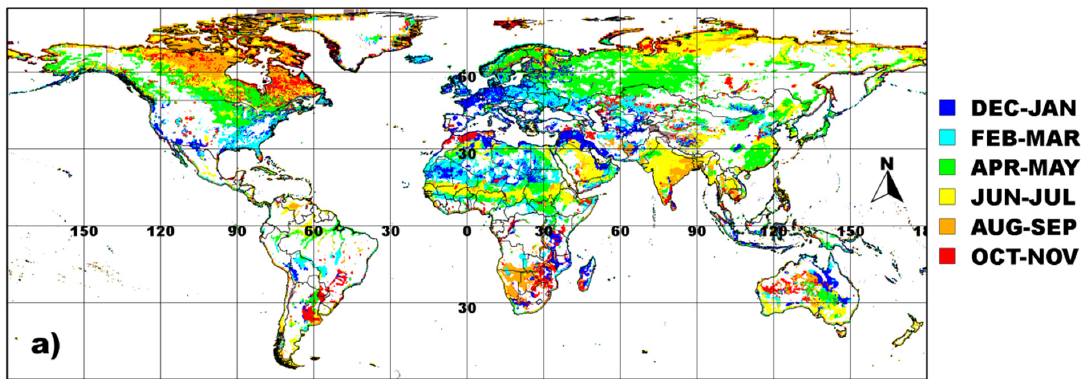
Figure 6. Cont. Figure 6. Cont .